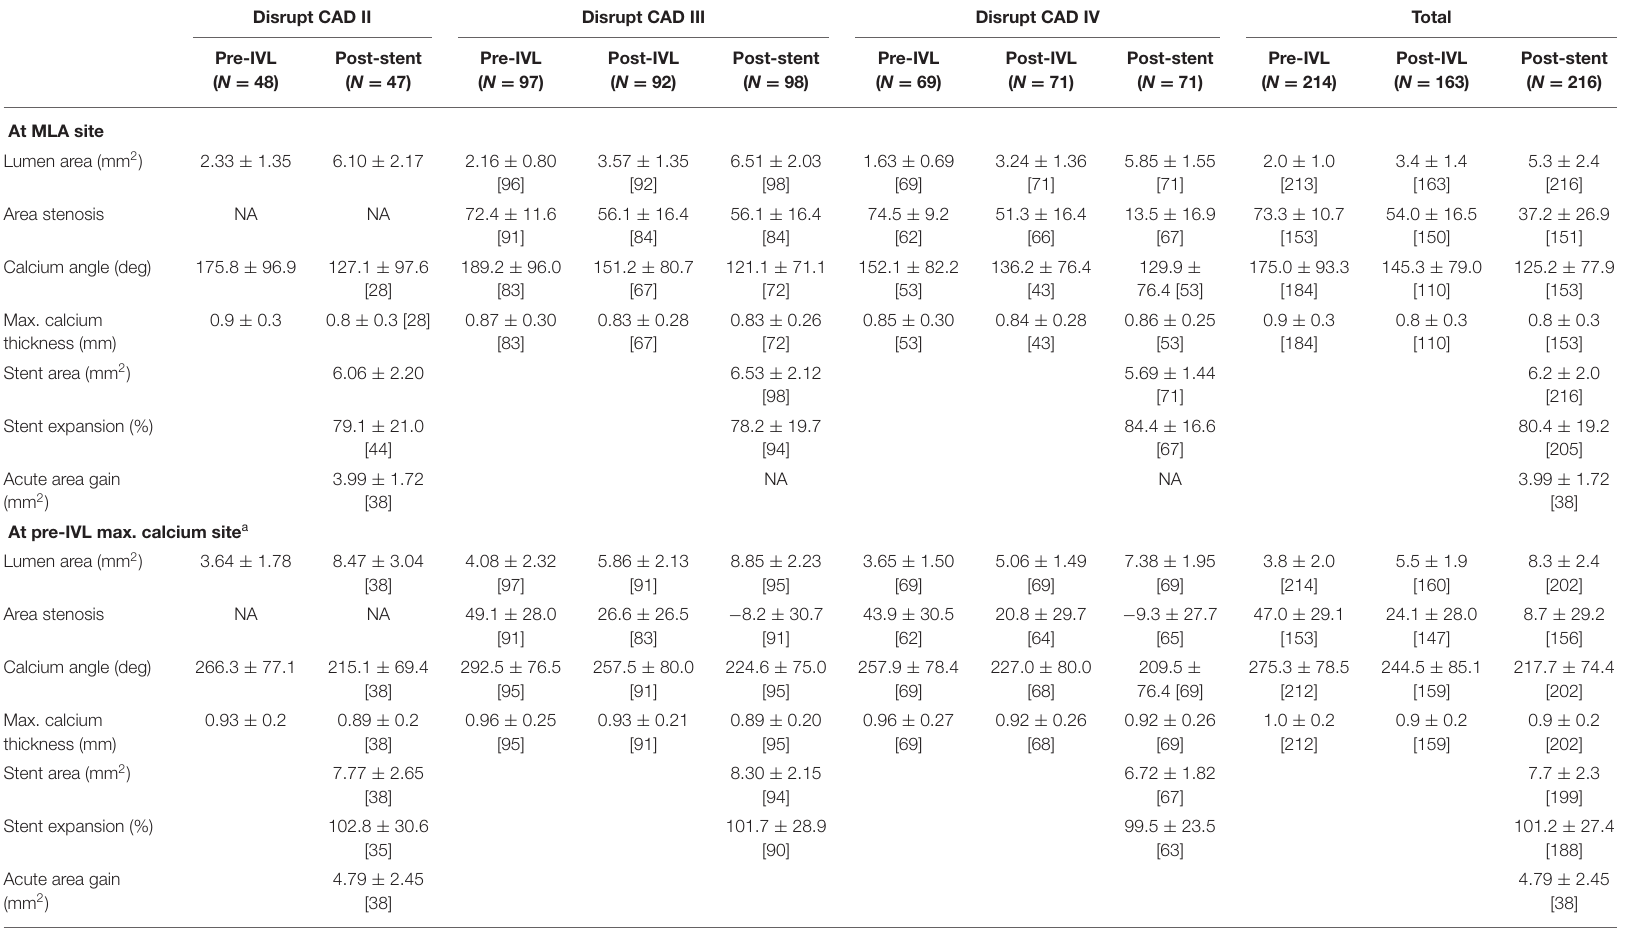
TABLE 7 | Serial OCT measurements and calcium fracture